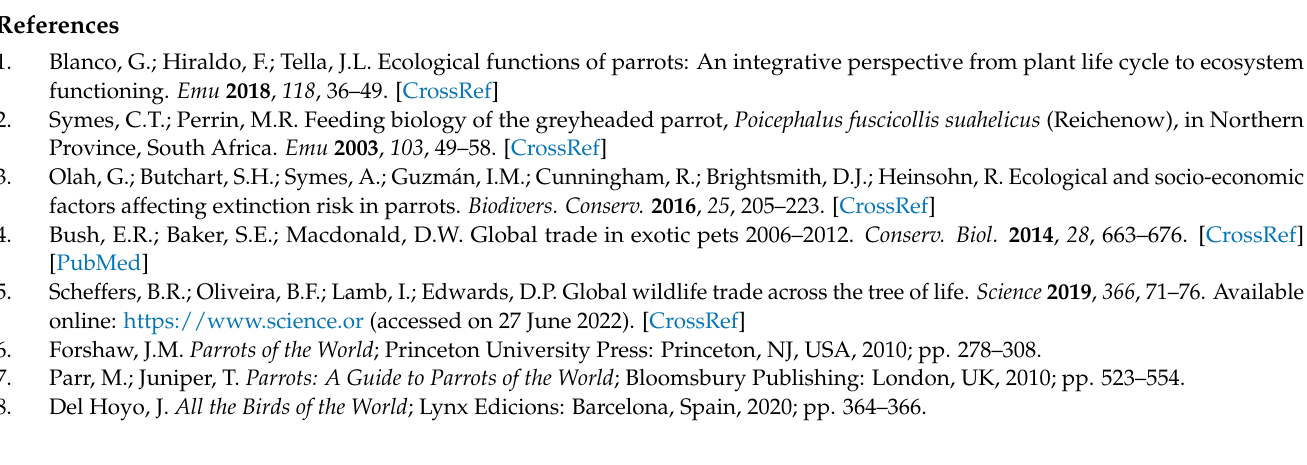
Table S6: Confusion matrix of the VGGNet16 model for the classification of the 26 Amazon parrot species; Table S7: Confusion matrix of the ResNet18 model for the classification of the 26 Amazon parrot species; Table S8: Confusion matrix of the ResNet34 model for the classification of the 26 Ama- zon parrot species; Table S9: Confusion matrix of the ResNet50 model for the classification of the 26 Amazon parrot species; Table S10: Confusion matrix of the DenseNet18 model for the classification of the 26 Amazon parrot species; Table S11: Confusion matrix of the DenseNet30 model for the classification of the 26 Amazon parrot species; Table S12: Confusion matrix of the DenseNet50 model for the classification of the 26 Amazon parrot